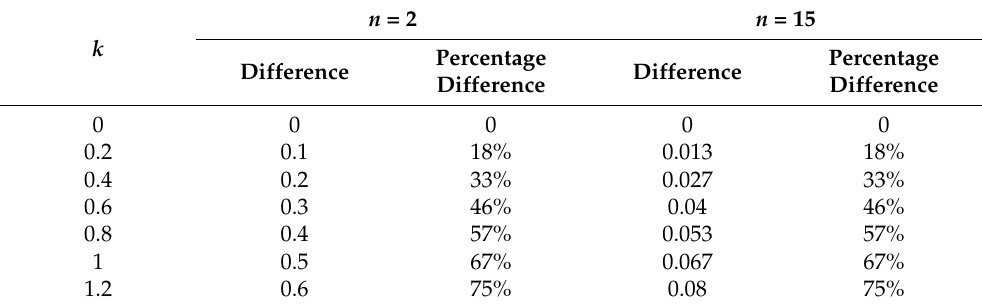
Table 3. Differences and percentage differences between the credit shares of the first and the last coauthors for n = 2 and 15 against the seven values of k